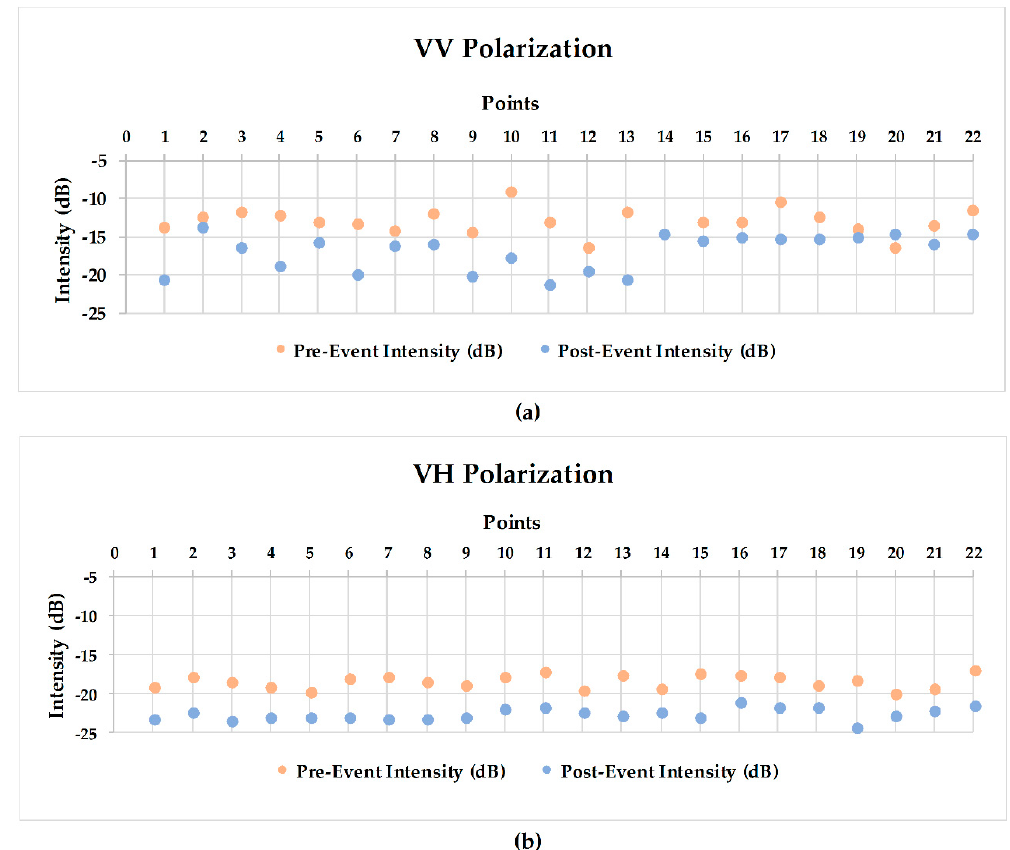
Figure 9. Graphical representation of the values of backscatter intensity before and after the event, for the VV ( a ) and VH ( b ) polarization, for the indicated points.